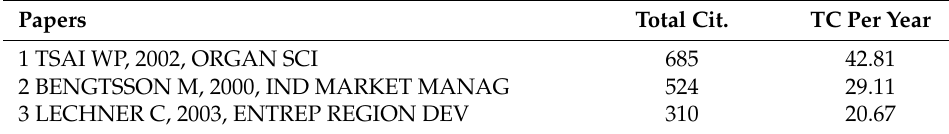
Figure 1. Annual scientific production. Table 2. The most cited